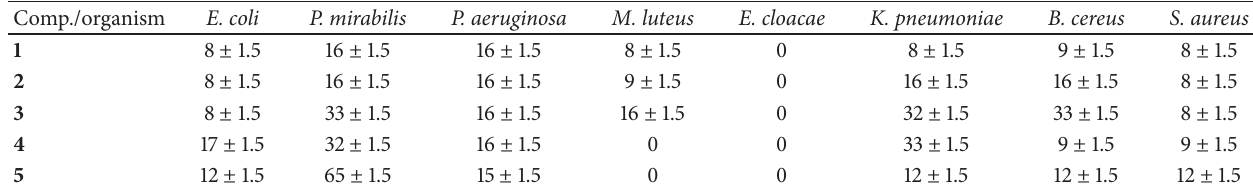
Table 5: MBCs ( 𝜇 g/mL) of 1–5 from C. sativum against bacterial strains. Comp./organism